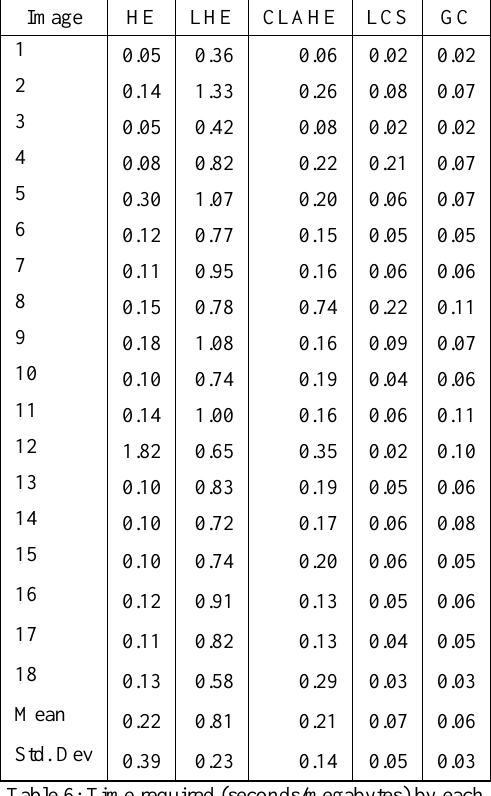
Table 6: Time required (seconds/megabytes) by each enhancement algorithm (columns) to process the 18 true color images. LHE required most time in comparison to LCS and GC.